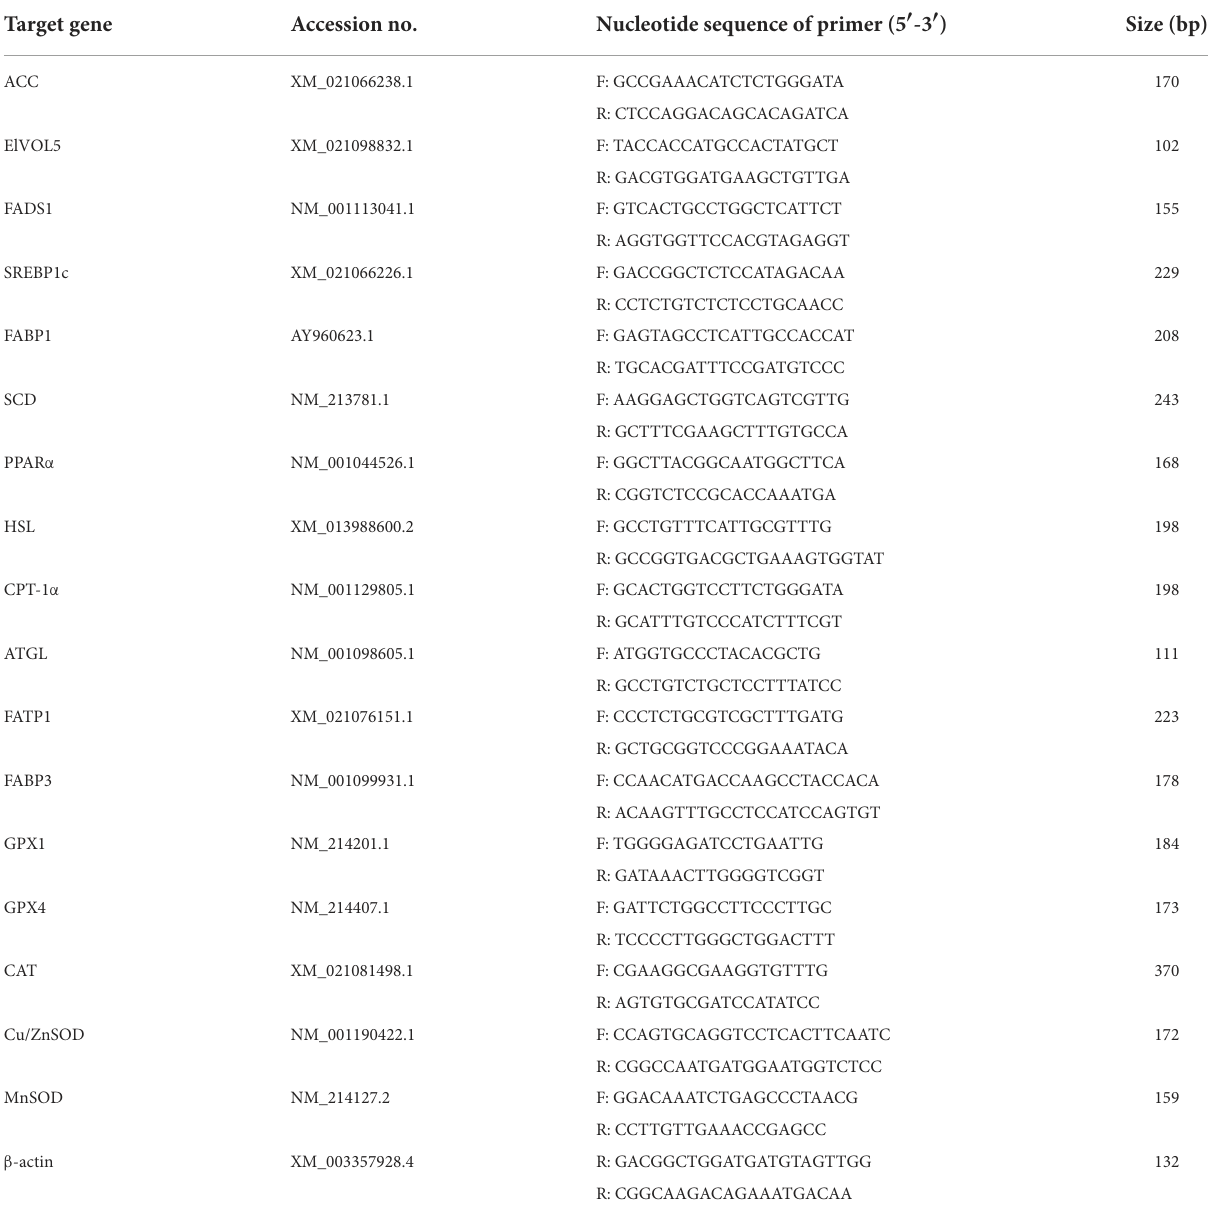
TABLE 2 Primers used for